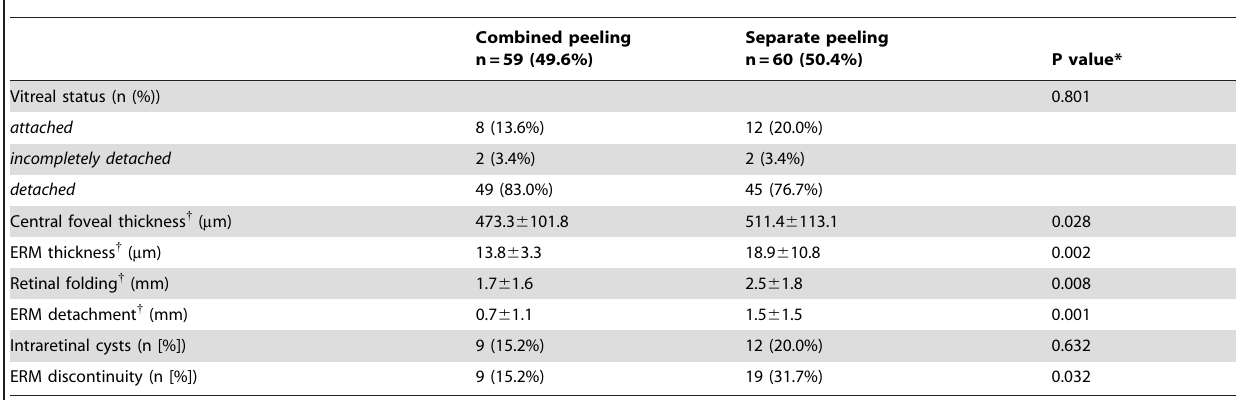
Table 1. Characteristics of eyes undergoing epiretinal membrane (ERM)